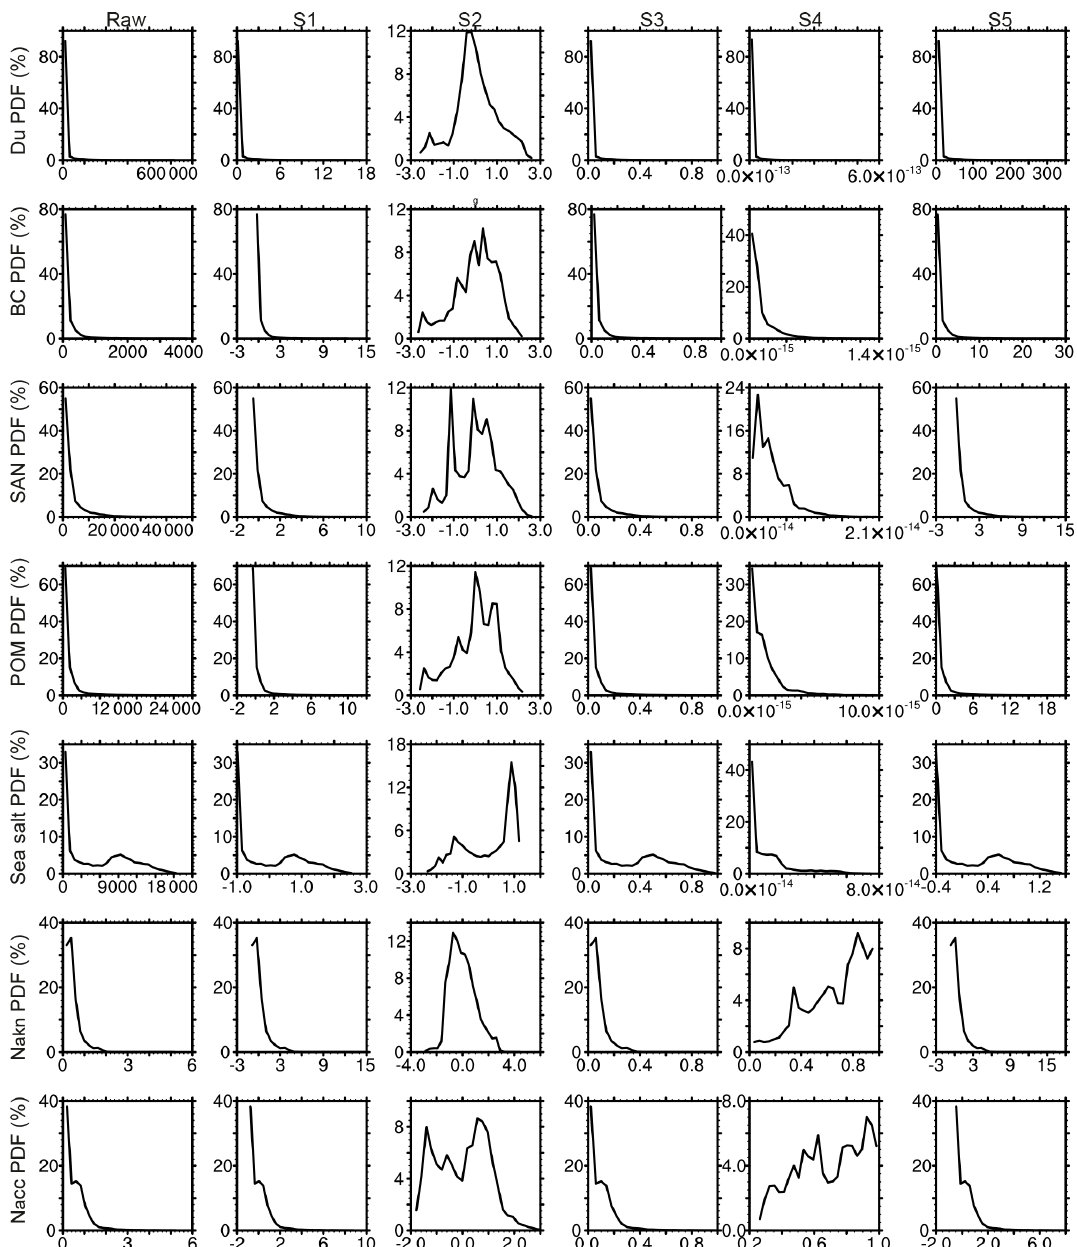
Figure 7. Probability density functions (PDFs) of the seven aerosol properties (rows) derived from their global lower-tropospheric distribu- tions in the raw (unscaled) data (first column) and after applying the S1–S5 scaling methods (second to sixth column). The units of the raw (unscaled) values are the same as in Fig.